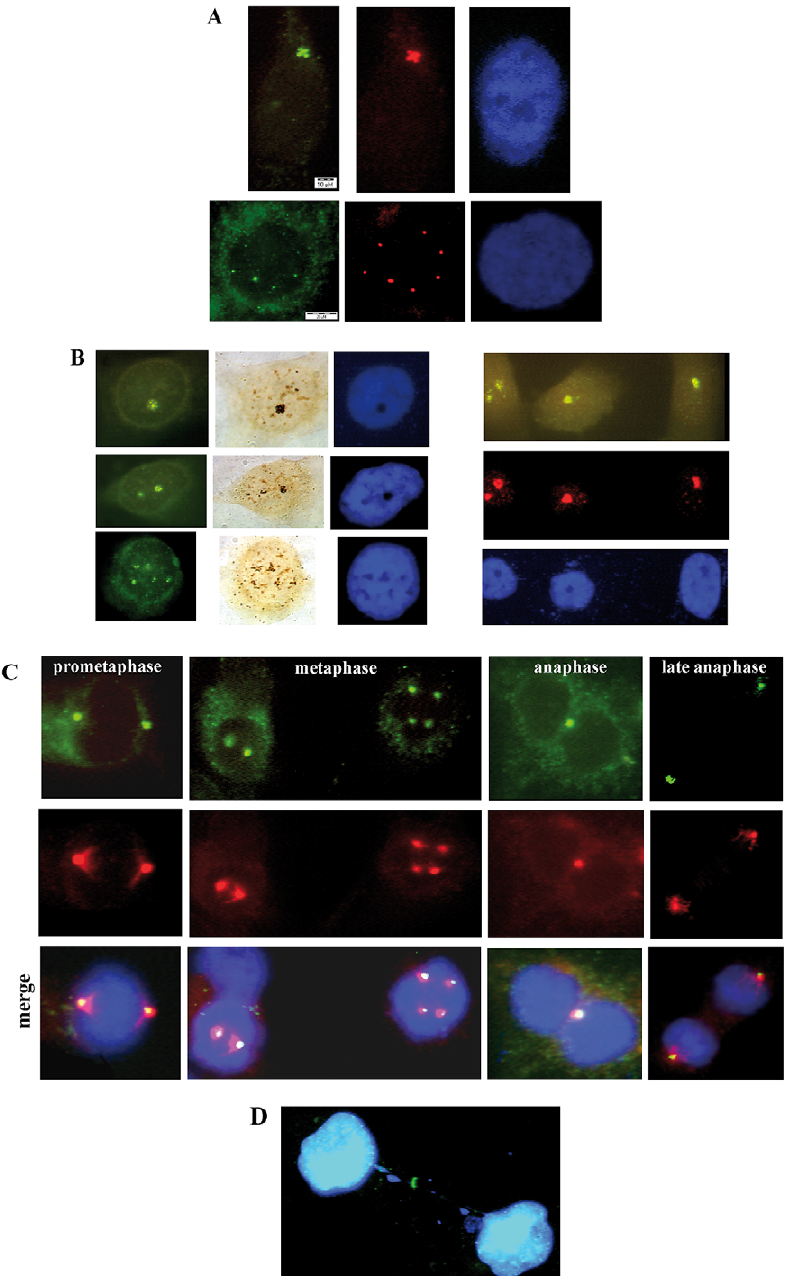
Fig. 3. Subcellular localization of MARK4L in glioma cell lines as revealed by IF. Magnification 63 × or 100 × . Scale bars = 10 µm (A, top), 20 µm (A, bottom). The nuclei are counterstained with DAPI. (A) Double MARK4L (green)- and γ -tubulin (red)-immunostained photomicro- graphs of MI-60 interphase cells showing the two main configurations of amplified centrosomes: a large clustered signal (top) and multiple random signals (bottom). (B) Anti-MARK4L antibody (green) and silver-colloid method showing nucleolar localization of MARK4L signals in G-91, MI-60 and MI-4 cells (left panel, top to bottom). Double-immunostaining of MARK4L (green) and nucleolin (red) showing co-localization to the nucleoli in MI-60 cells (right panel). (C) Cells from the MI-60 cell line representative of all mitotic phases following dual IF labelling with MARK4L (green) and γ -tubulin (red). (D) Localization of MARK4L (green) to the midbody formed during cytokinesis in MI-60